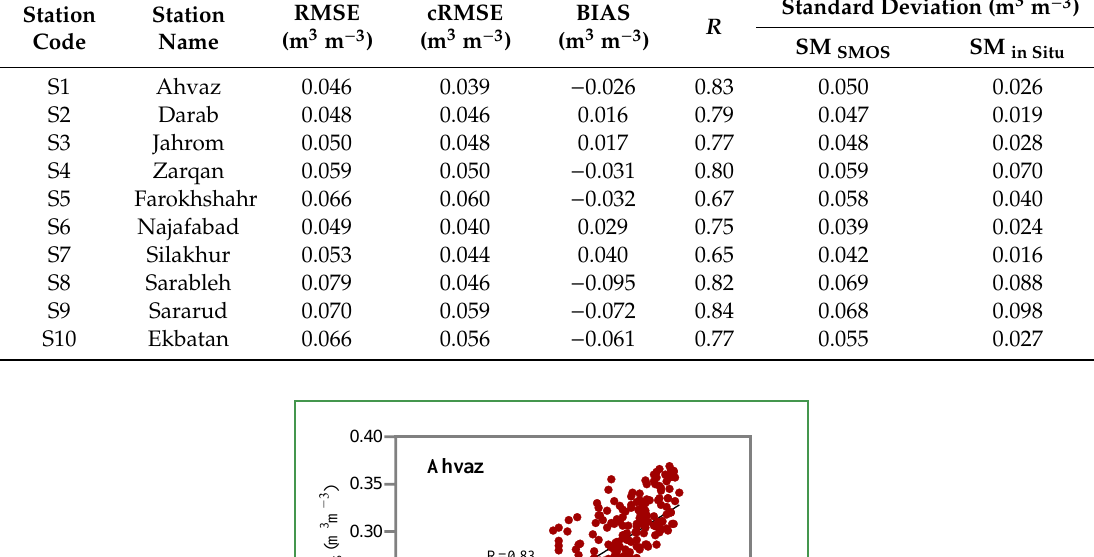
Table 5. Statistical results of SM SMOS compared to ground-based SM in situ at the stations.